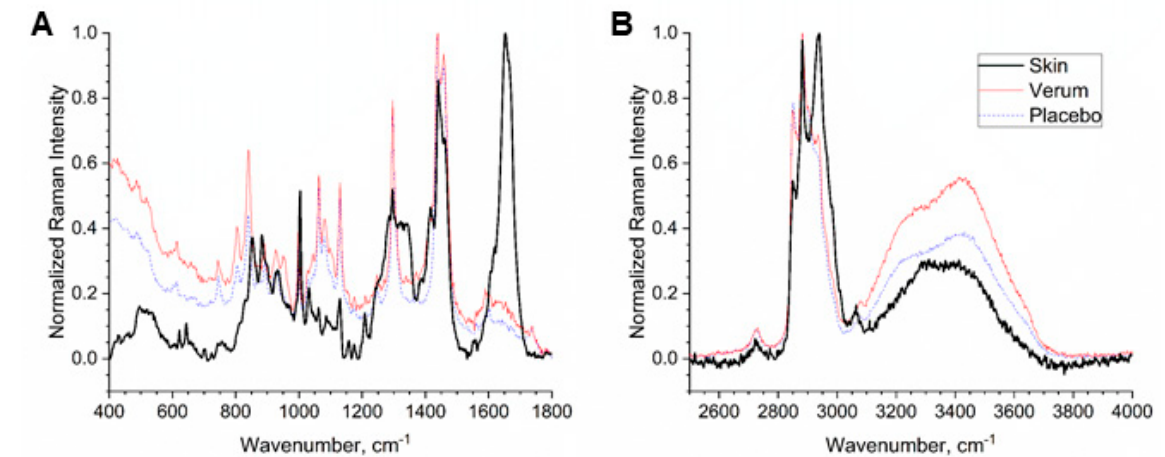
Figure 1. Normalized mean Raman spectra of untreated human stratum corneum (SC) in vivo in 3.4 µm depth (black), the verum (red) and placebo formulations (blue) in the fingerprint (FP, A ) and high wavenumber (HWN, B ) regions.